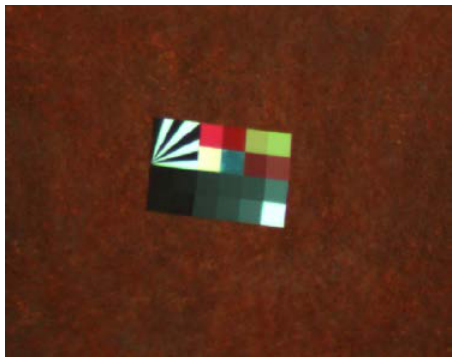
Figure 11. The PIQuAT- image obtained with miniMCA,